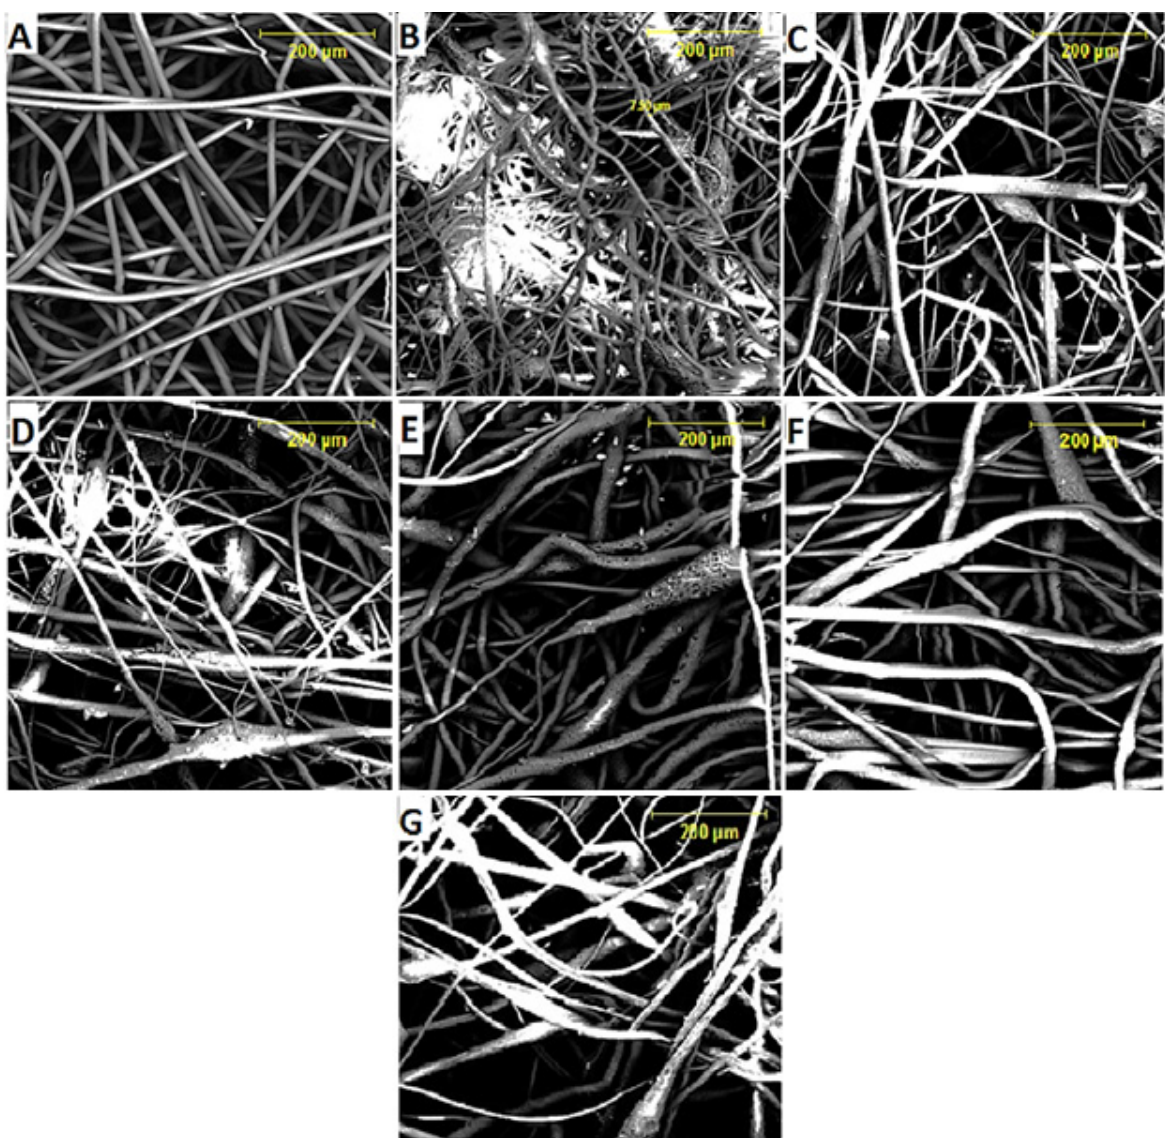
Figure 11. ( A – G ) SEM Morphologies of treated CCP-PLA nanofibres at different wt.% CCP: ( A )